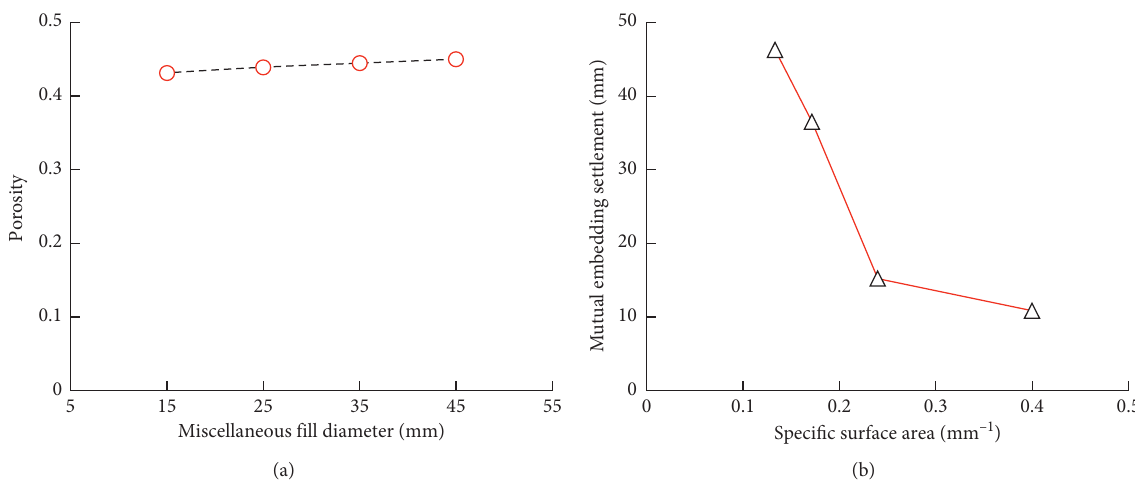
Figure 8: Effects of miscellaneous fill diameter on structural characteristics of miscellaneous fill: (a) relationship between porosity and miscellaneous fill diameter; (b) relationship between mutual embedding settlement and specific surface area of particles.